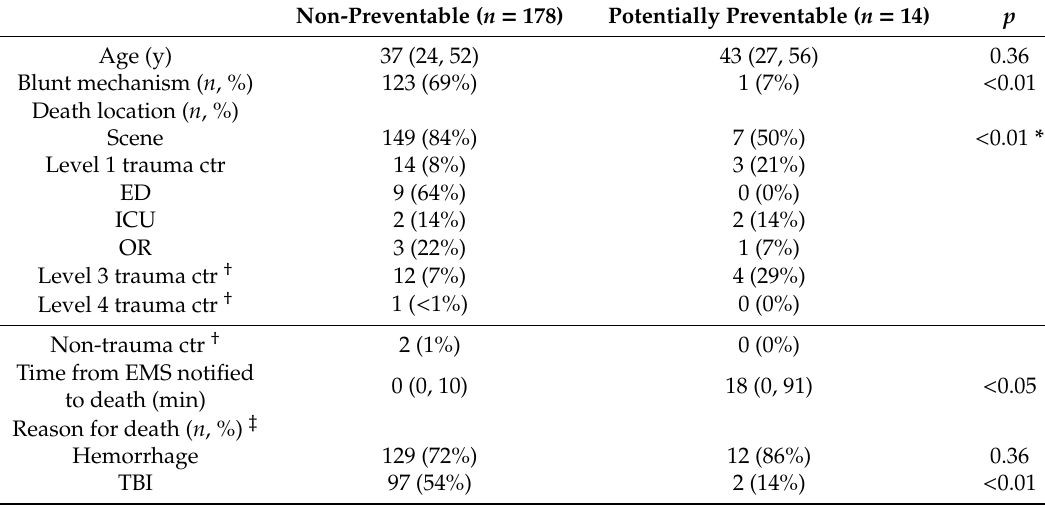
Table 1. Demographics and death